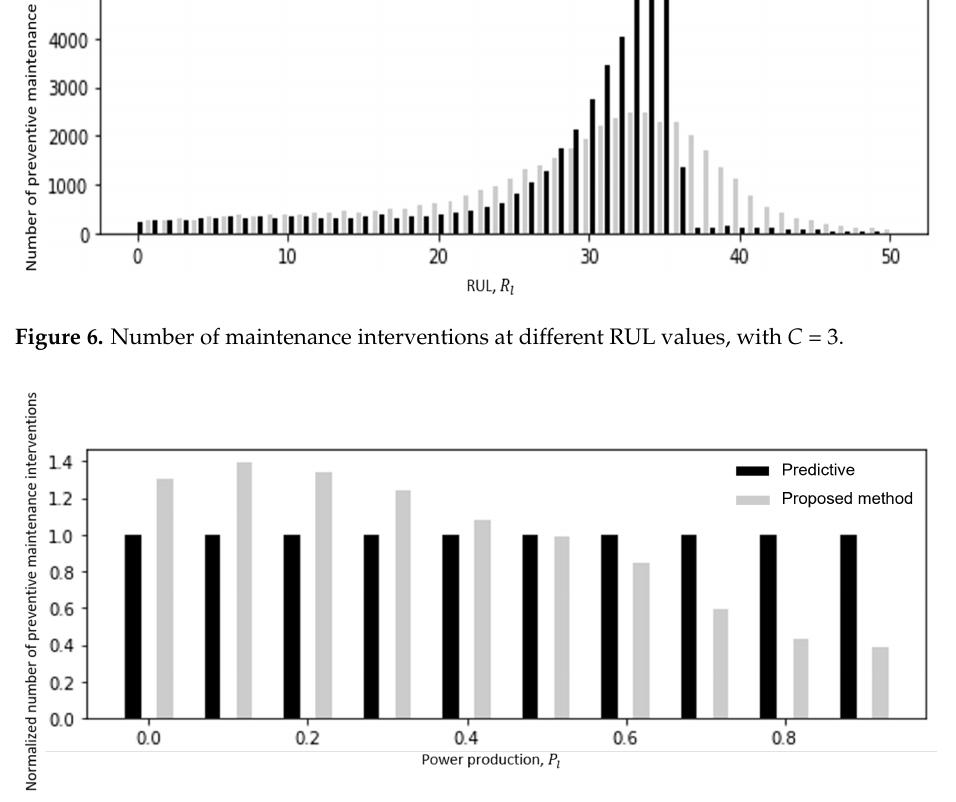
Figure 7. Number of maintenance interventions at different power production values, with C =